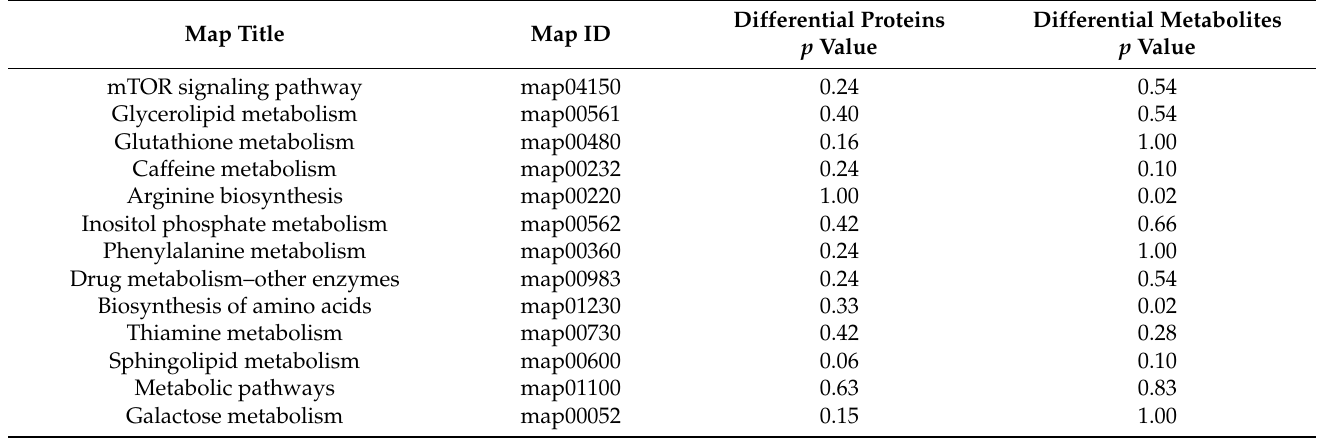
Table 4. Pathway enrichment statistics of differential proteins and differential metabolites in male